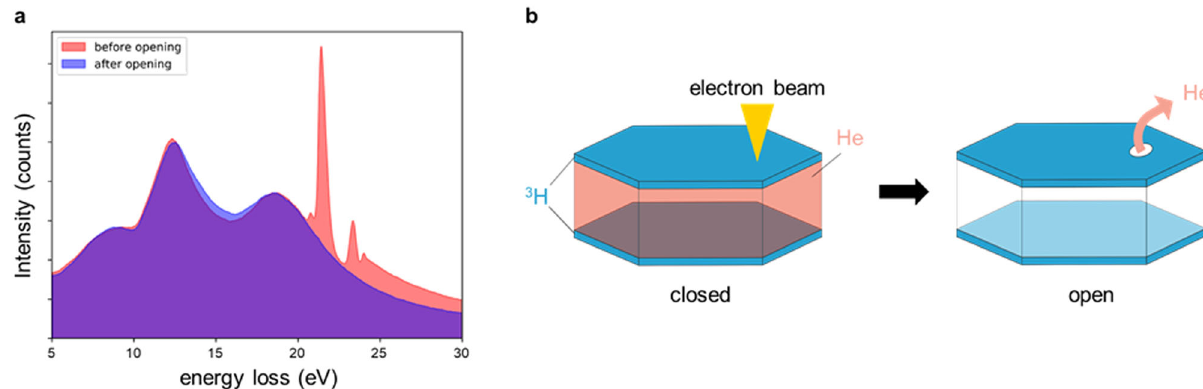
Fig. 3 In situ opening of bubbles with the electron beam. a Comparison of the EEL spectra, before (red) and after (blue) the bubble was opened. b Schematic of the proposed He/H arrangement within the hexagonal bubbles 68 .